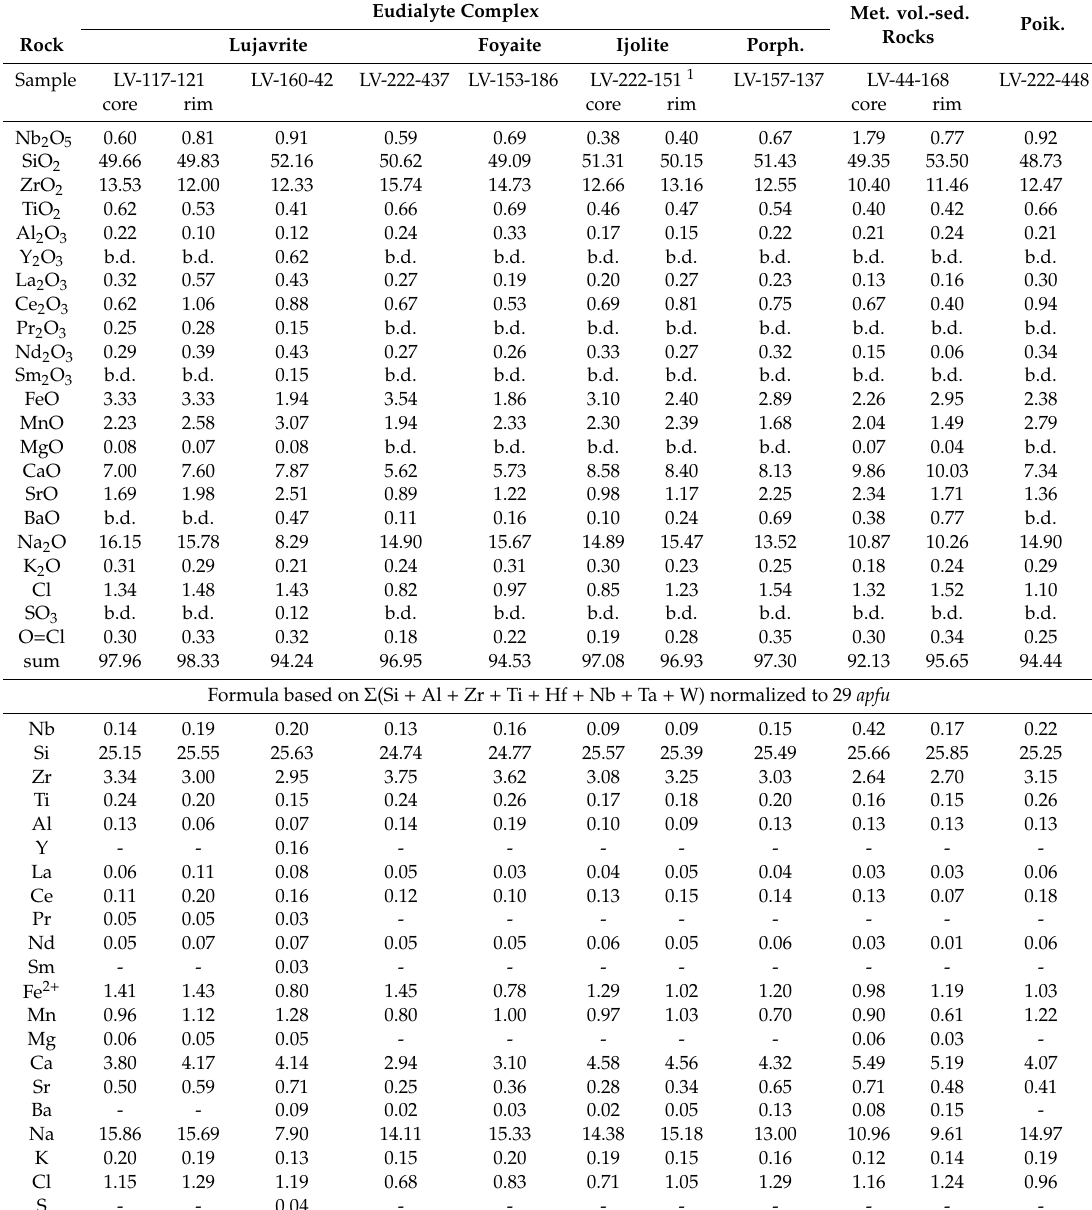
Table 3. Representative microprobe analyses of the EGM, wt.%. Eudialyte